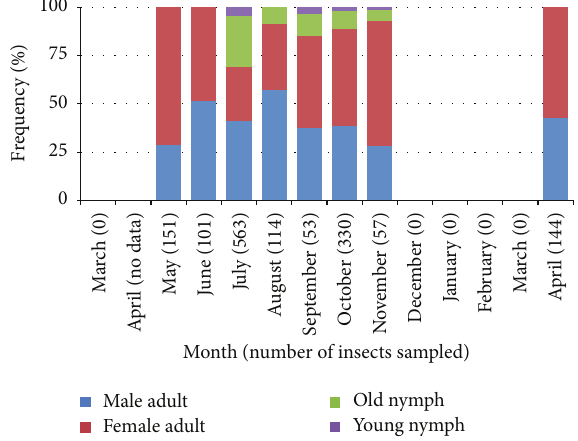
Figure 3: Seasonal changes in the composition of developmental stages of H. septentrionalis from March 2014 to April